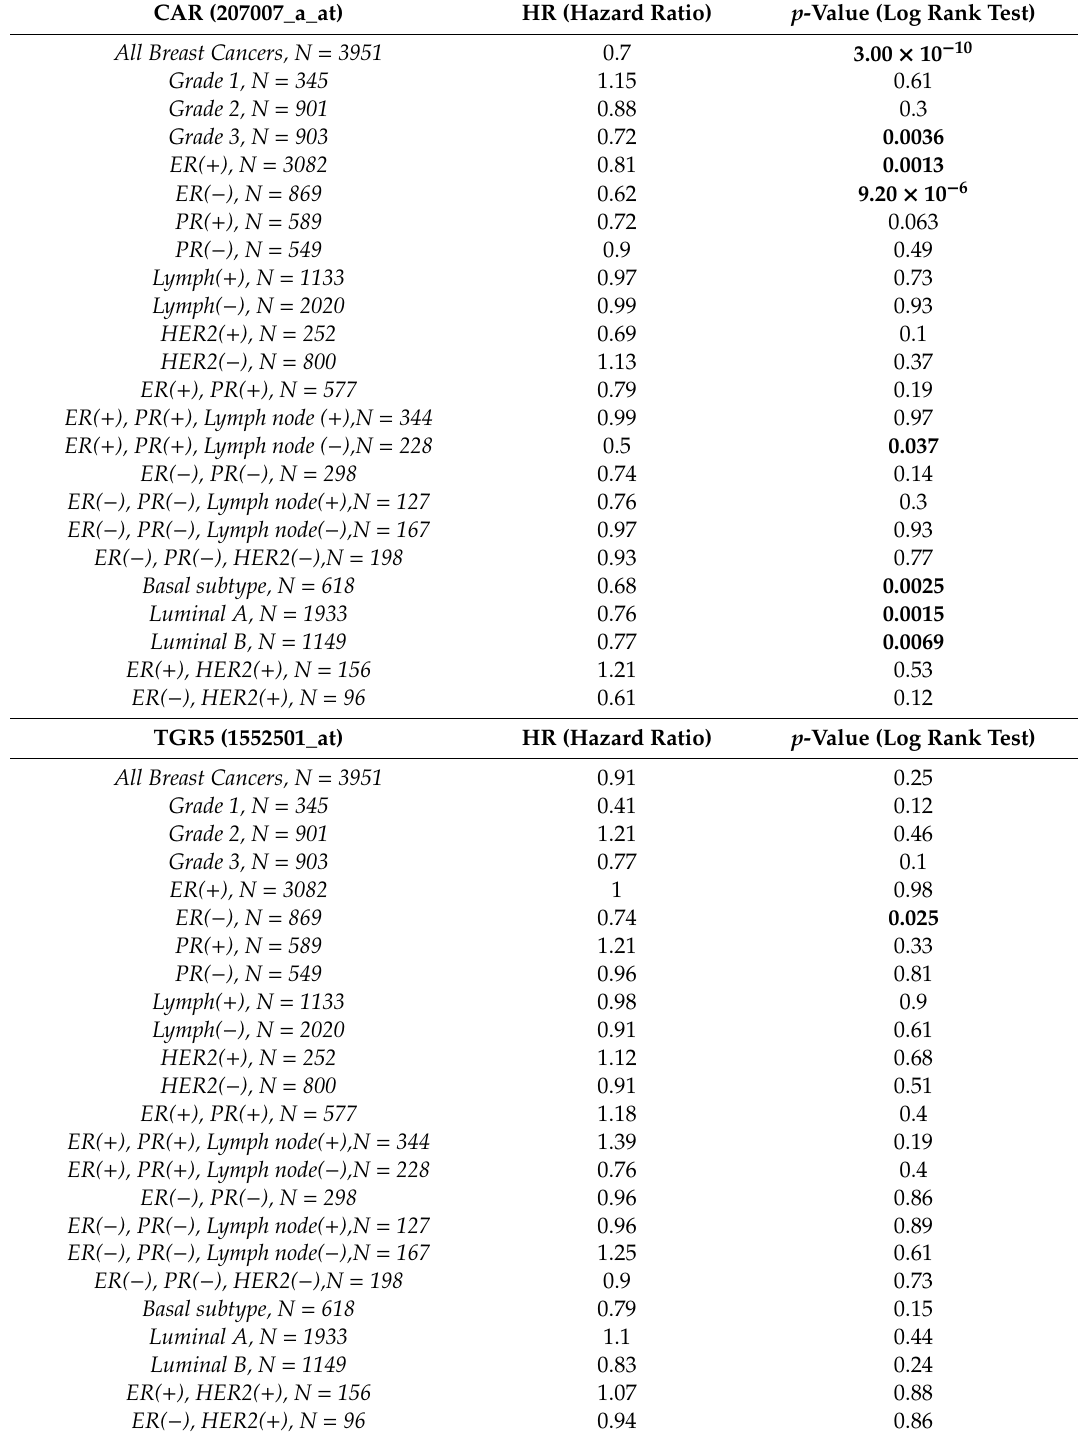
Table 4. Connection between iNOS, nNOS, TGR5, CAR, NRF2, and breast cancer patient survival. Bold numbers represent statistically significant